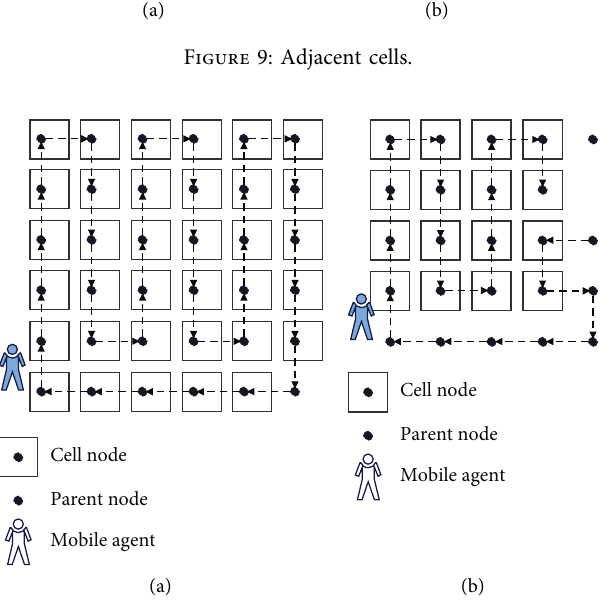
Figure 10: Single MA traversal path.